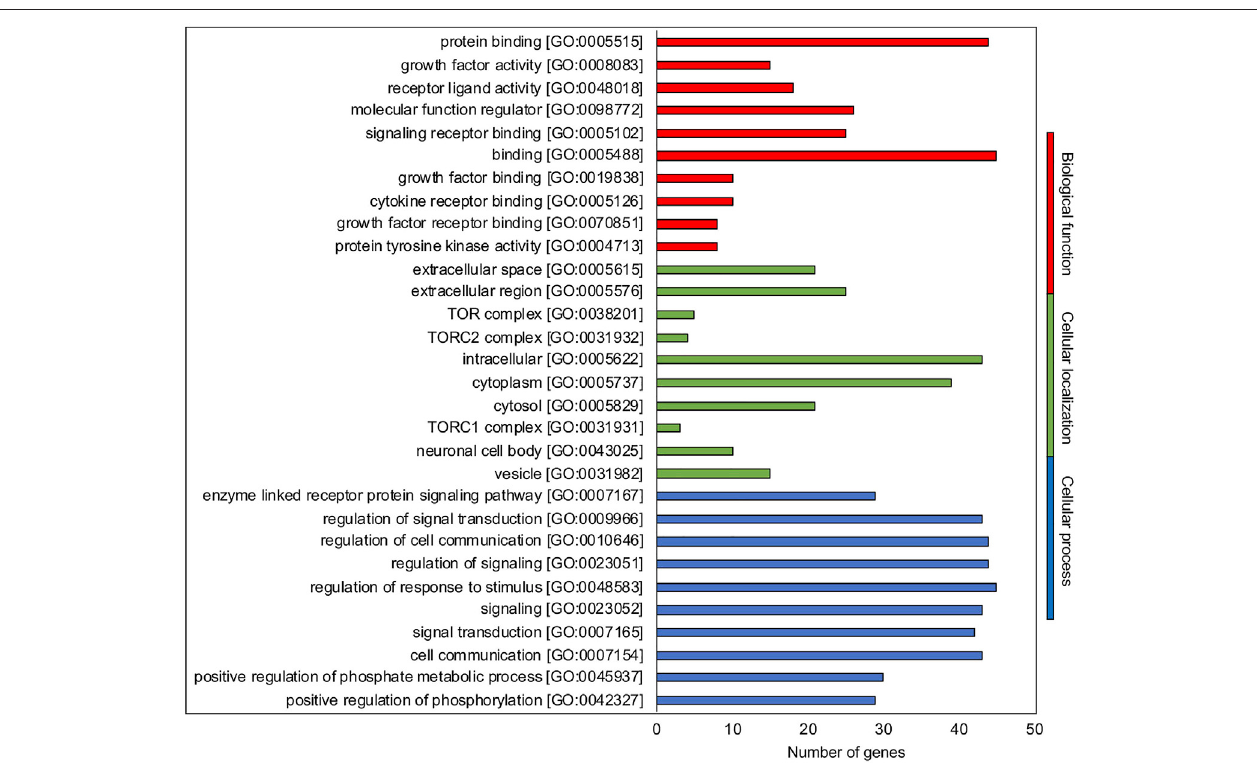
FIGURE 1 | GO enrichment analysis. Representative scheme of the top 10 most abundant GO terms identi fi ed for the hub.BN molecules in the three GO categories: biological function (red), cellular localization (green), and biological processes (blue). The x -axis indicates the hub.BN molecules in a speci fi c category, while the y -axis indicates different GO